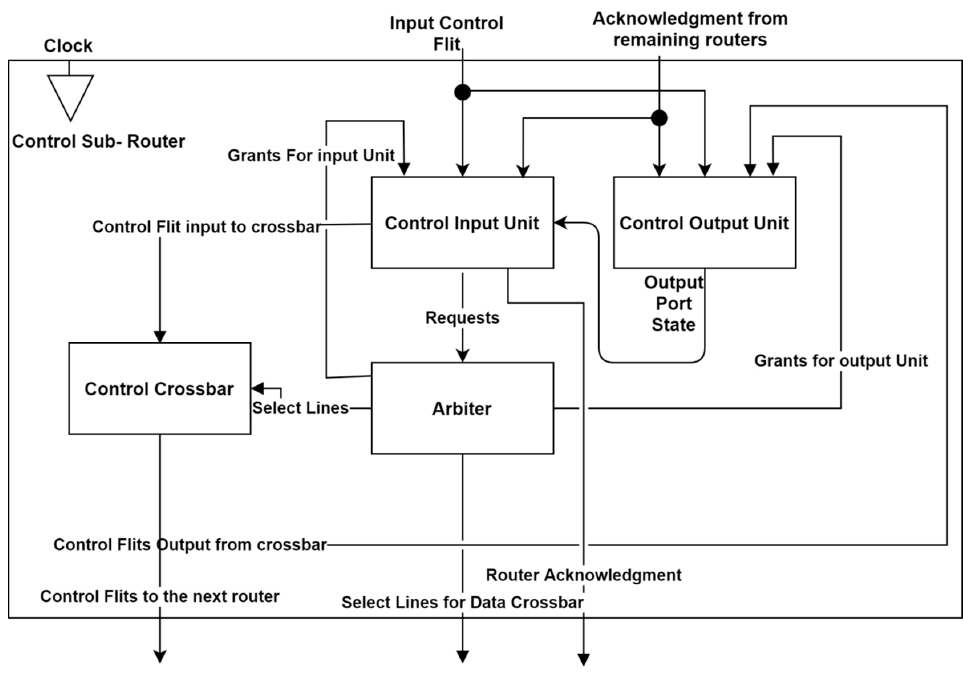
Figure 5. The internal design for the control subrouter with the arbiter, crossbar, input and output units.